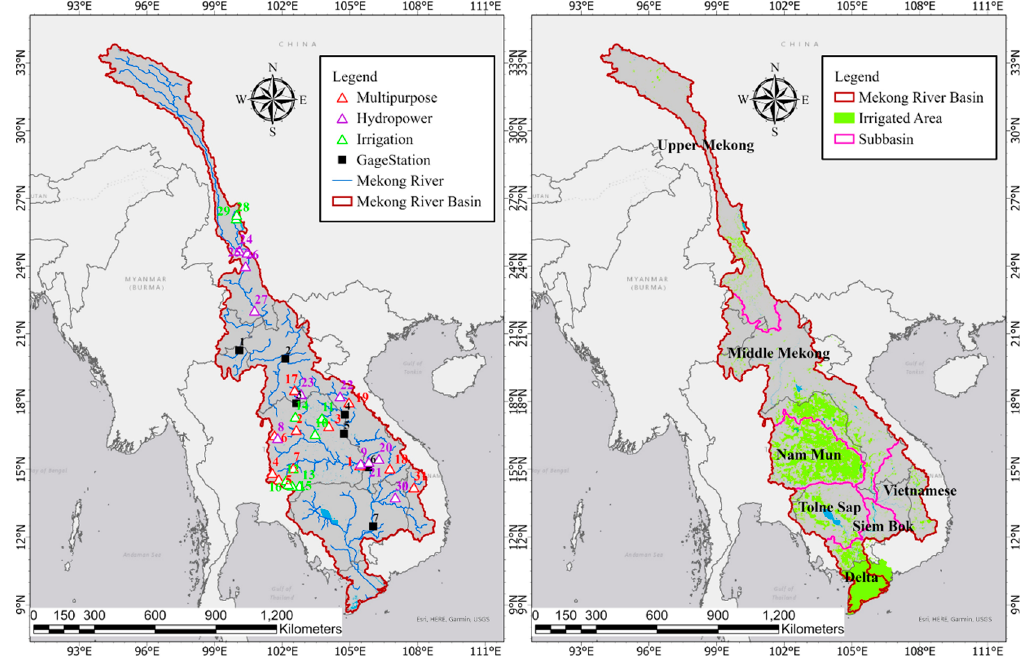
Figure 1. The Mekong River Basin, including irrigated areas and various types of dams. Irrigated wet season rice is grown all year and fish catch (4.4 million tons per year)